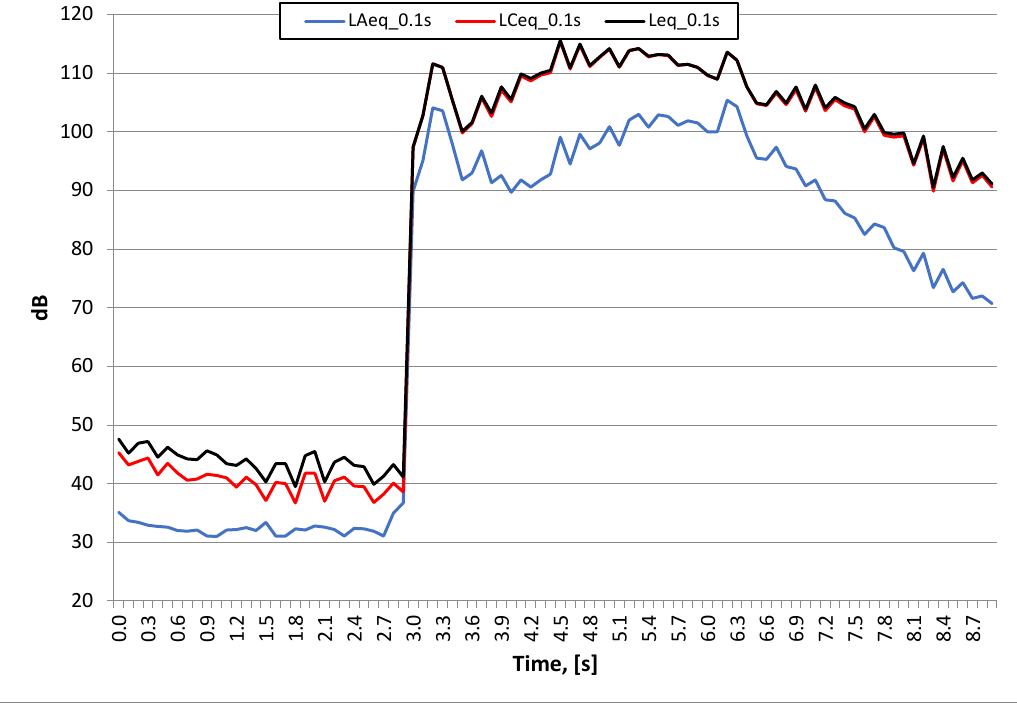
Figure 8. Test No. I: sound pressure level waveform sine sweep in the range of 30 – 300 Hz (ZZ17); stand 5.